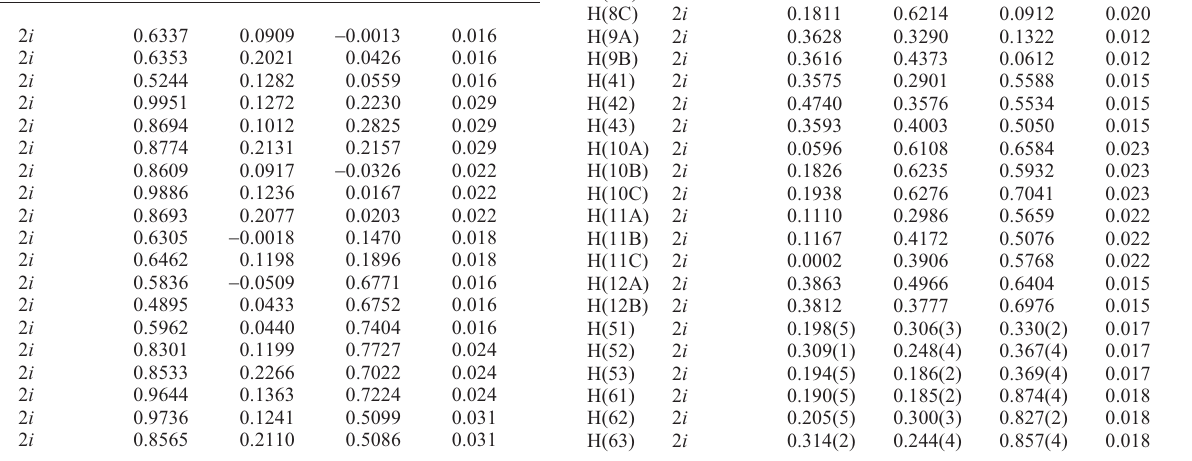
Table 3. Atomic coordinates and displacement parameters (in Å 2 )